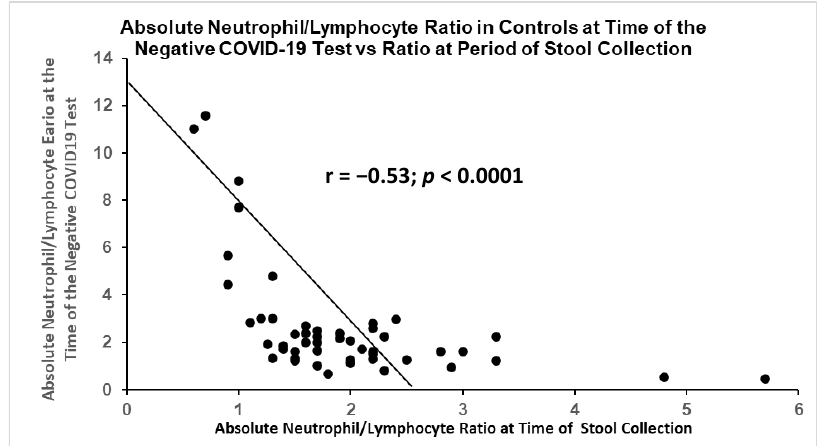
Figure 15. Inverse correlation between sets of NLR obtained at time of initial stool collection and during time of non-COVID-19 related symptoms.